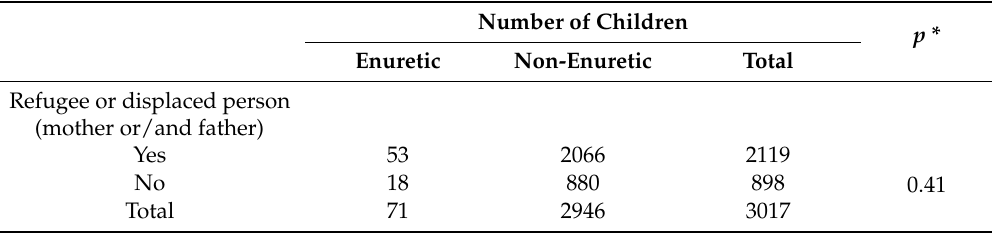
Table 4. Parental refugee or displaced person status and their children’s